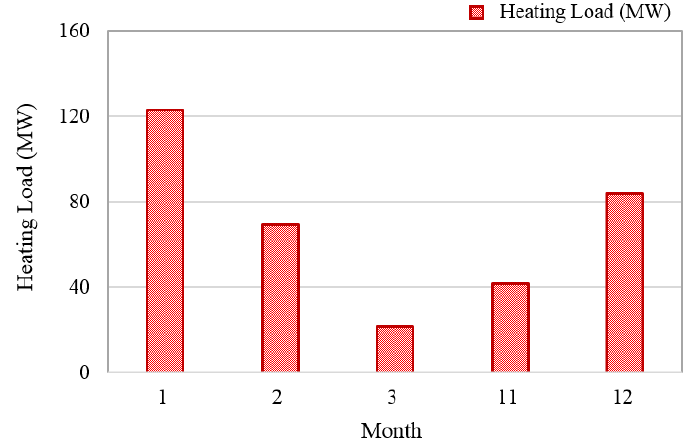
Figure 14. Monthly heating load of object building. Table 5. Calculations of peak loads of each floor of object building.